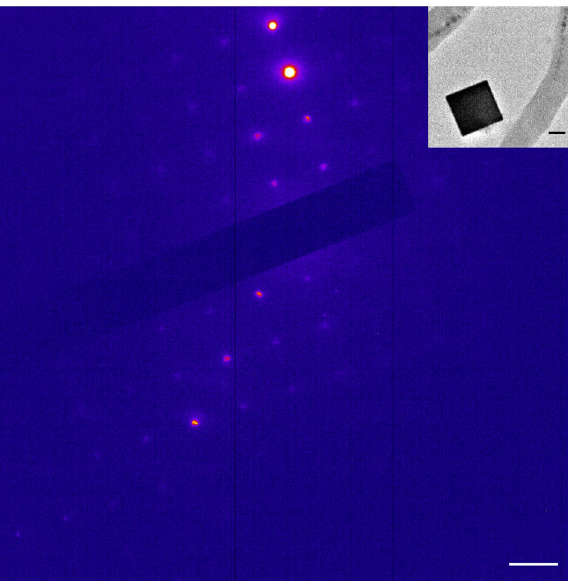
Figure 7. Selected area electron diffraction (SAED) pattern of an insoluble Prussian blue (PB) single crystal (see image in inset), aligned with a four-fold symmetry axis to the electron beam. The diffraction pattern and reciprocal lattice spacing of 0.985 nm −1 is consistent with the simple cubic lattice of insoluble PB (space group P m -3 m, lattice constant 1.0166 nm). Scale bar 1 nm −1 , scale bar inset 100